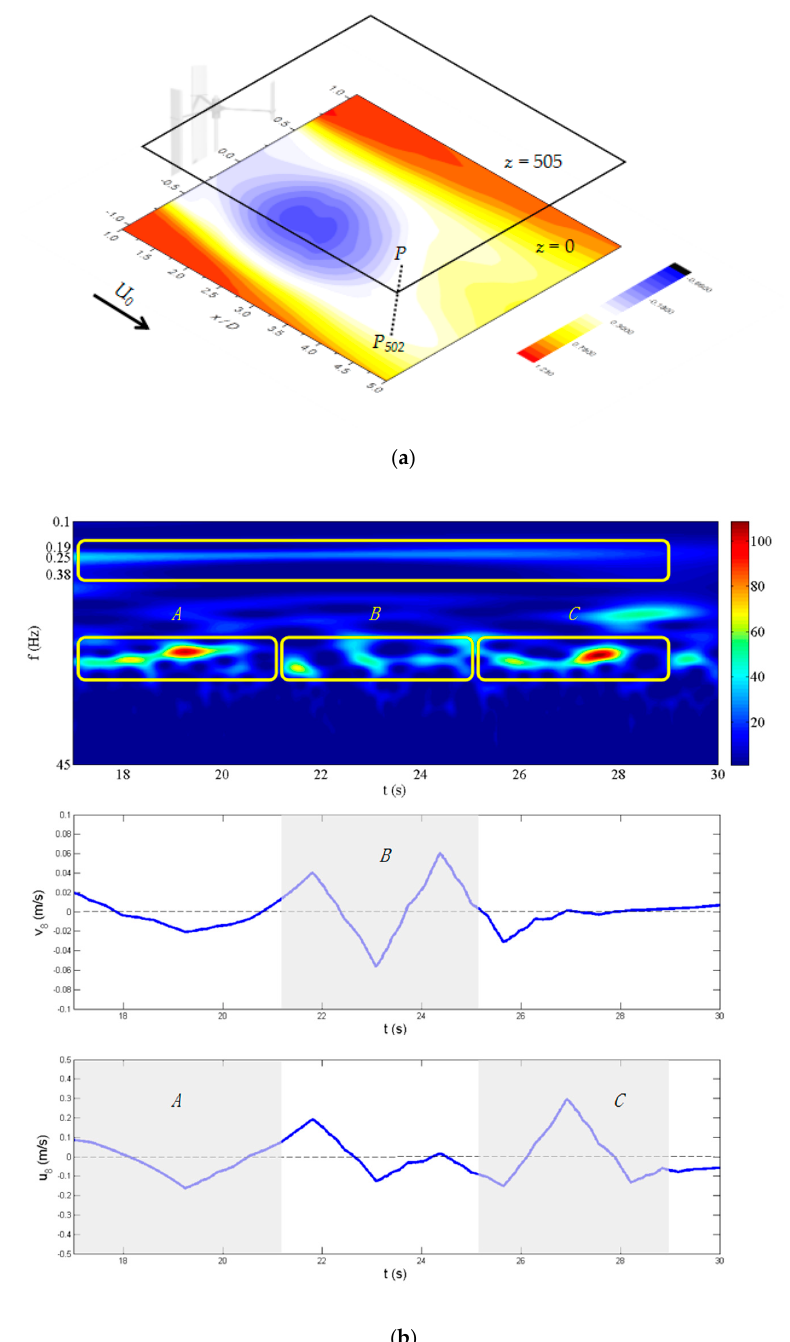
Figure 12. For a wind turbine wake with configuration C, P (3000, − 540, 505) was selected in the z = 505 mm plane. P and P 502 (3000, − 540,0) are at different vertical positions of the wake shear layer. ( a ) schematic diagram, ( b ): The top image is the wavelet spectrum of the time series signal of the streamwise fluctuating velocity at P 502 , the central image is the eighth layer high-frequency component ( d 8 ) of the time series signal of the spanwise fluctuating velocity at P and the bottom picture is the eighth layer high-frequency component ( d 8 ) of the time series signal of the streamwise fluctuating velocity at P ; P and P 502 were measured synchronously.